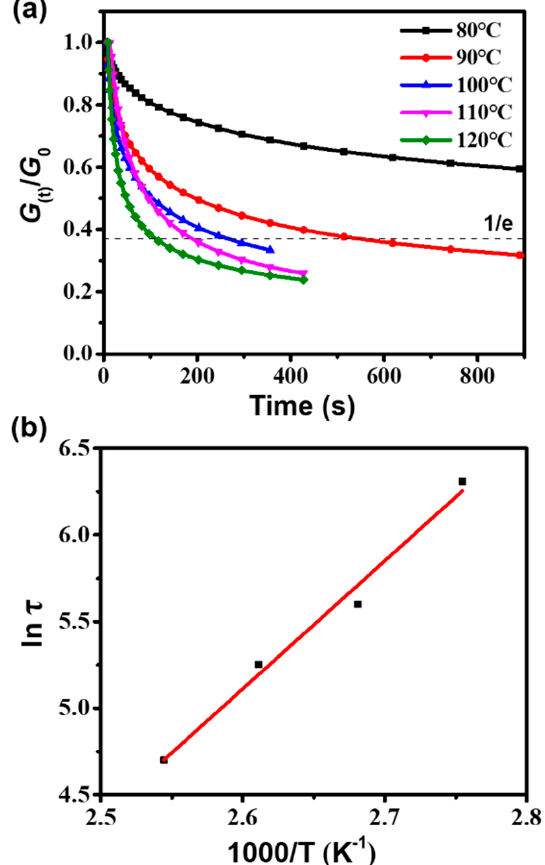
Figure 3. ( a ) Normalized relaxation modulus as a function of time of the polyhexahydrotriazine thermoset (PHT) at di ff erent temperatures. ( b ) The Arrhenius fitted line between ln ( τ ) and 1000 /